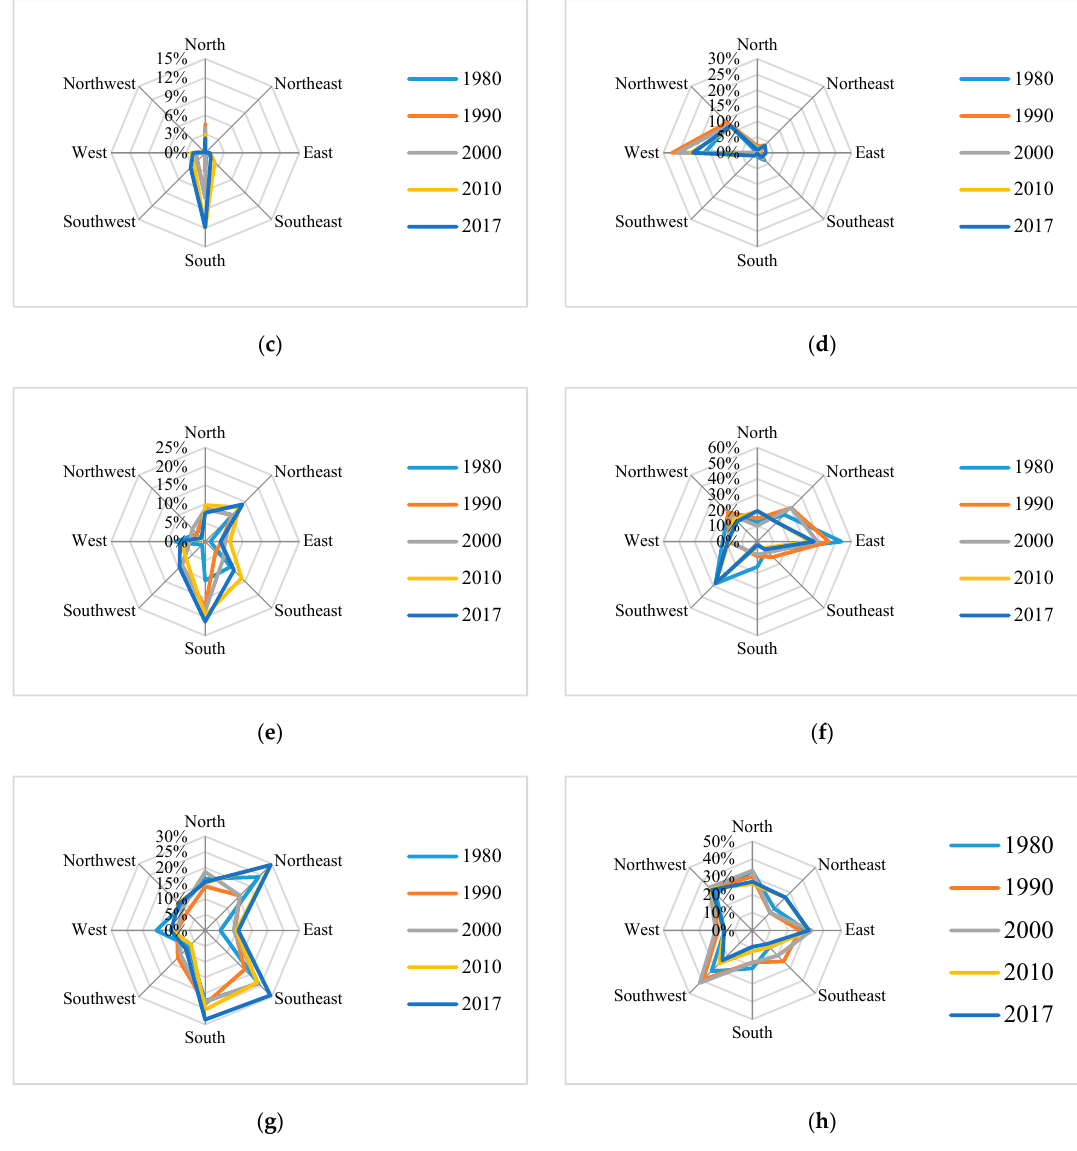
Figure 11. Change of spatial diversity in 8 directions ( a ). Proportion of the hotspot in 8 directions ( b ). Proportion of the cold spots in 8 directions ( c ). Proportion of the hot spot-high area change in 8 directions ( d ). Proportion of the cold spot-high area’s change in 8 directions ( e ). Proportion of the hot spot-middle area’s change in 8 directions ( f ). Proportion of the cold spot-middle area change in 8 directions ( g ). Proportion of the hot spot-low area change in different quadrants ( h ) Proportion of the cold spot-low area change in 8 directions.